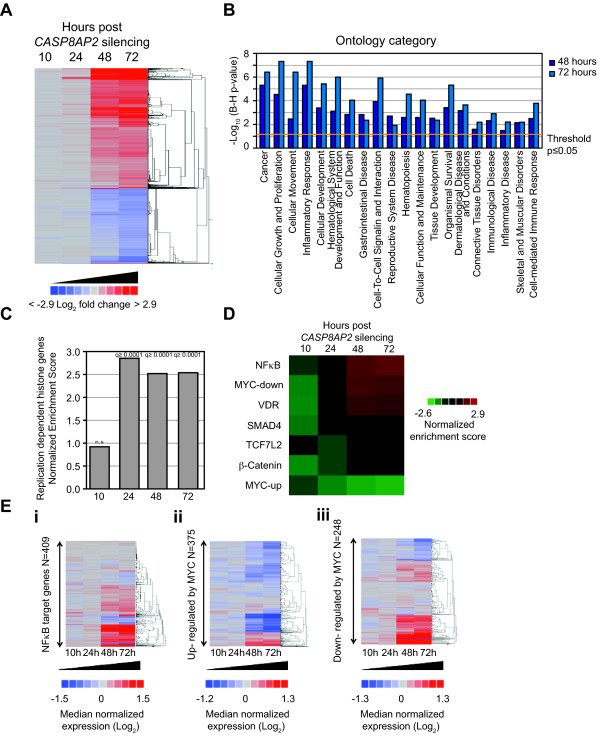
The loss of CASP8AP2/FLASH function induces consistent effects on the transcriptome of CRC cells. (A) Heat map representation of the median fold change for those transcripts showing a significant fold change (> ± 0.6 Log2 fold change, p < 0.05) at 72 hours post-transfection for all three siRNAs corresponding to CASP8AP2/FLASH when compared to the expression profiles obtained for siNeg transfected SW480 cells generated at the same time points. Data at earlier time points reflects the fold changes seen for all of these transcripts, though these changes in expression may have not reached significance. (B) The enrichment of functional ontologies for upregulated genes with the CASP8AP2/FLASH RNAi signatures obtained 48 and 72 hours post siRNA transfection. No statistically significant enrichment was seen for genes showing a downregulation in expression within the CASP8AP2/FLASH RNAi signature. (C) Gene set enrichment analysis of the human histone genes at 10, 24, 48 and 72 hours. (D and E) Gene set enrichment analysis of the targets of transcription factors associated with CRC. (D) Shows the overall statistical analysis for the enrichment of the targets within the CASP8AP2/FLASHRNAi signature for six transcription factors, (E)(i) shows the enrichment plots for the targets of NFκB over time, (ii) shows the enrichment plots for the upregulated targets of the MYC transcription factor over time, and (iii) shows the enrichment plots for the downregulated targets of the MYC transcription factor over time.